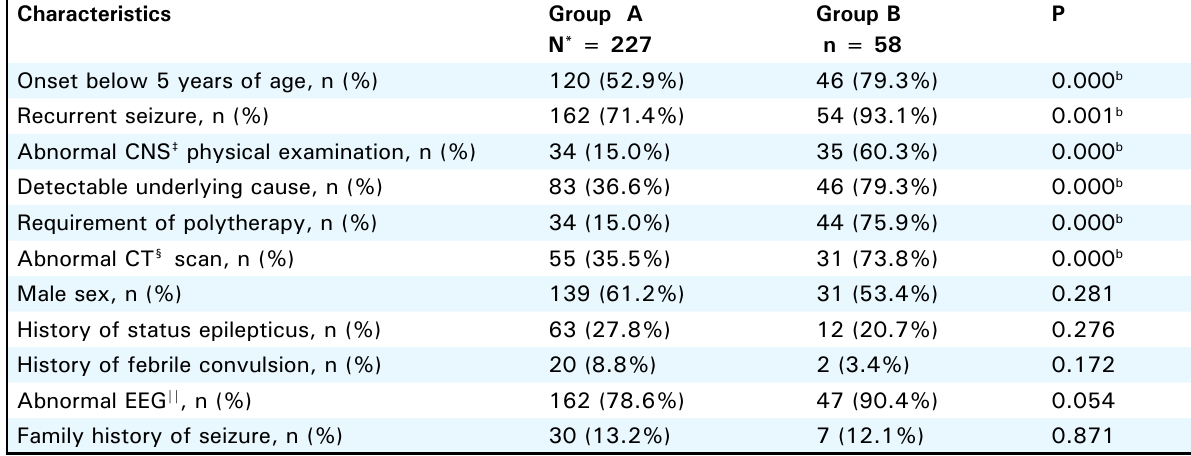
Table 5. Comparison of predicting factors between children who achieved (Group A) and who did not achieve (Group B) good seizure control.